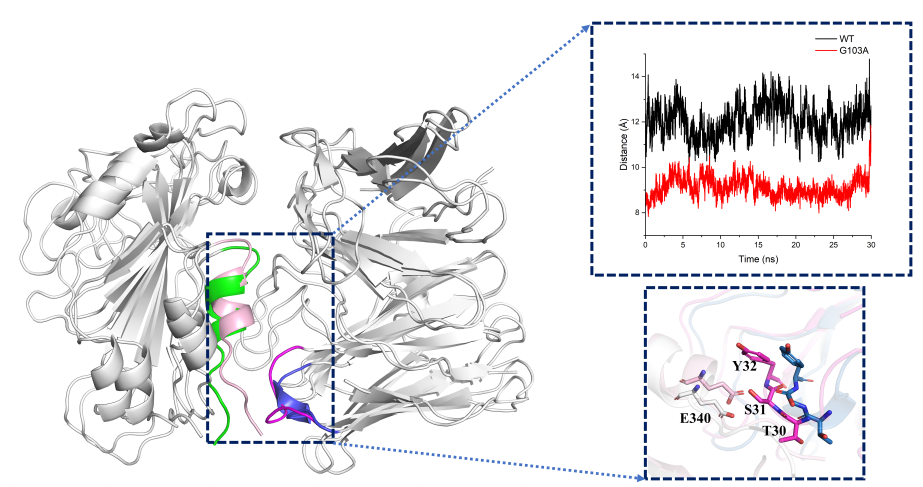
Figure 10. Distance and conformational changes of key residues on the binding surface of wild-type and mutant type: wild-type: green is the region of RBD L335-K356 residues, blue is the region of the heavy chain of antibody P28-Y32 residues; mutant type: light pink is the region of RBD L335-K356 residues, magenta is the region of the heavy chain of antibody P28-Y32 residues (for easy observation, all glycans of the system have been hidden in the figure). The graph shows the distance between the center of the mass of antigen residues L335-E340 and antibody residues P28-Y32; black is the WT system; red is the G103A system; and the input trajectory file is the 30 ns equilibrium trajectory of WT, G103A and